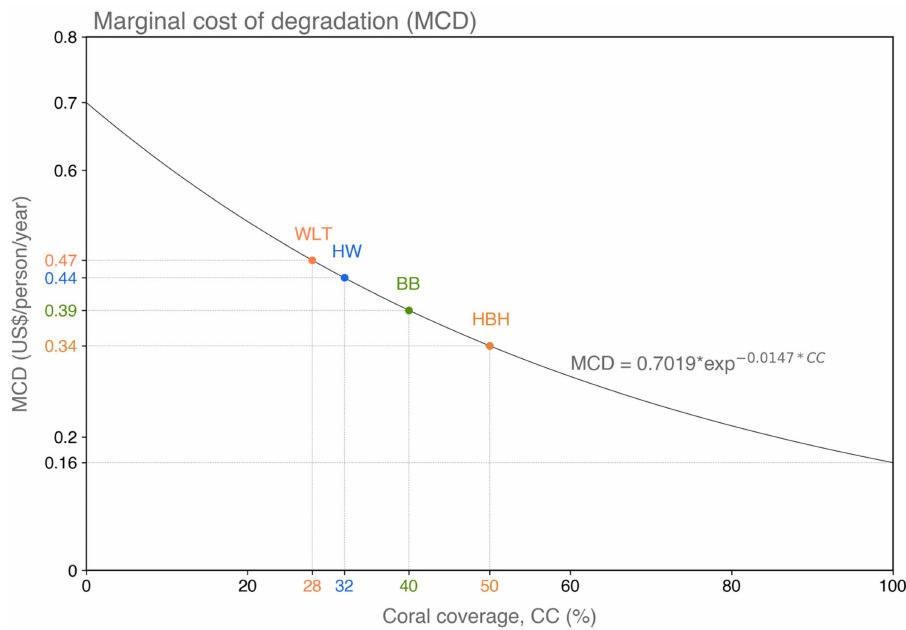
Figure 5. Marginal cost of degradation as a function of coral coverage (US$ / person / year) WLT: Wanlitong, HW: Houwan, BB: Banana Bay and HBH: